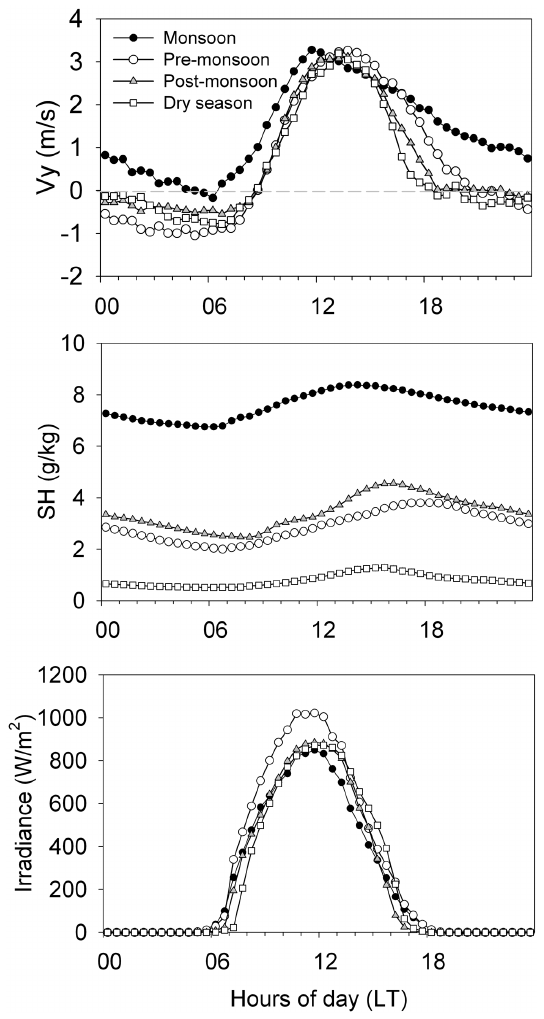
Fig. 4. Average seasonal diurnal variations of southerly wind com- ponent (Vy, upper plate), specific humidity (SH, middle plate) and solar irradiance (bottom plate) at NCO-P during the pre-monsoon (white circles), monsoon (black circles), post-monsoon (grey trian- gles) and winter (white squares)